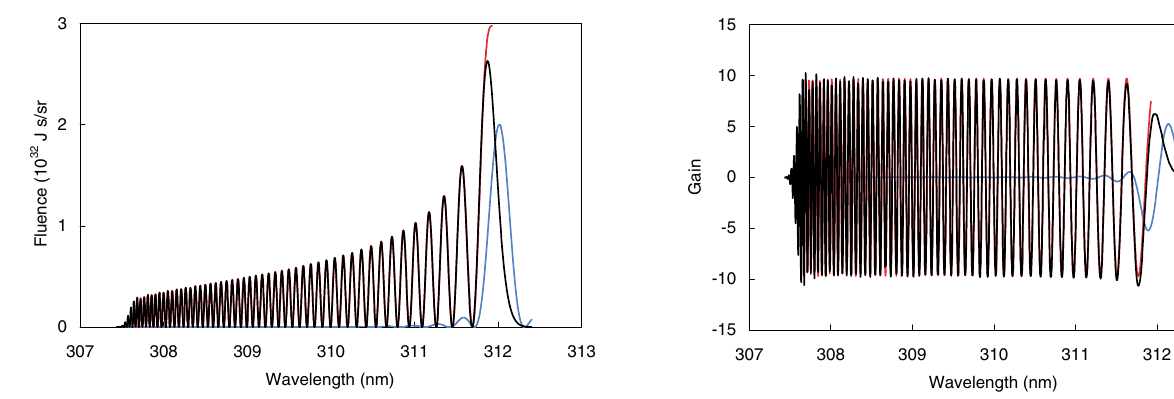
FIG. 2. (Color) Angular spectral fluence versus wavelength (fundamental only). The asymptotic approximation is shown as a black line and the stationary-phase approximation as a red line extending upward from the main peak. The blue line (shifted slightly to the right of the main peak) shows the fluence for the equivalent square